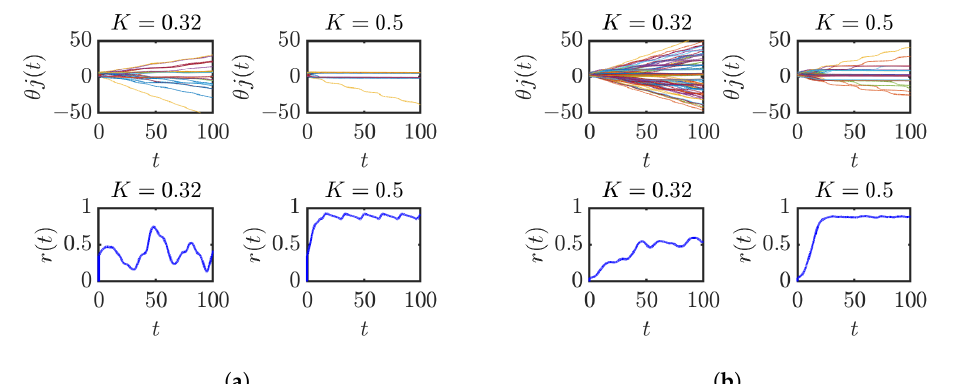
Figure 2. Synchronization pattern: 32 vs. 256 oscillators. The critical value K c is expected to reach closer to 0.32 (exact value in the thermodynamic limit, N → ∞ ) with the increase in the number of oscillators. Two partially synchronized groups are visible in the 32 oscillator case ( a ), while there are many of them in the case of 256 oscillators ( b ). Additionally, the fluctuation in the typical r ( t ) vs. t plot, which is proportional to N − 1 2 , is less prominent in the case of the 256 oscillator system compared to 32